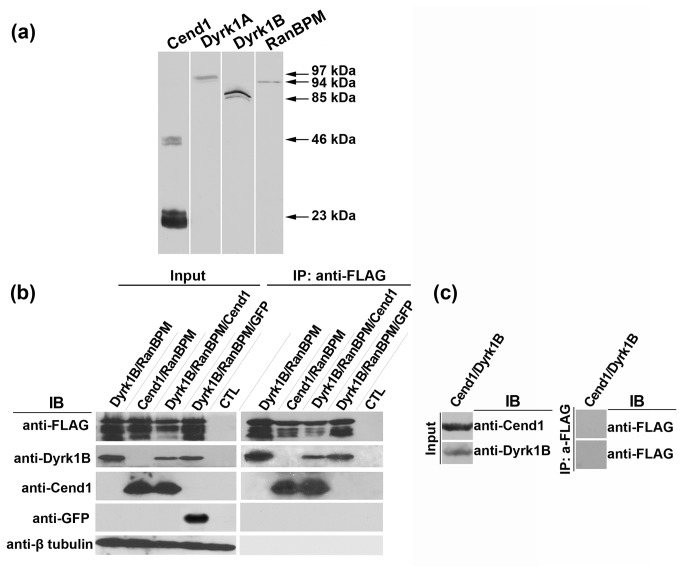
Cend1, RanBPM and Dyrk1B kinase are expressed in mouse brain and form complexes.(a) Mouse brain homogenate (60 μg of protein per lane) was subject to SDS-electrophoresis and immunoblotting with antibodies to Cend1 (lane 1), Dyrk1A (lane 2), Dyrk1B (lane 3) and RanBPM (lane 4). In lane 1 the 23kD band corresponding to the single polypeptide chain of Cend1 is seen as well as residual disulfide bond-linked 46kD homodimer [24,25]. (b) HEK293T cells were either not transfected (CTL) or transiently transfected with Cend1, RanBPM, Dyrk1B and GFP at the indicated combinations. Cells were harvested and RanBPM was immunoprecipitated from cell lysates using anti-FLAG antibody. Co-immunoprecipitated proteins were identified by Western blot using the indicated palette of antibodies. In the left panel, shown is the total cell lysate (input) with the different protein bands detected in each case. In the right panel, shown are the proteins which were co-immunoprecipitated with RanBPM in each case. (c) HEK293T cells were co-transfected with Cend1 and Dyrk1B and immunoprecipitated with anti-FLAG antibody. Note that anti-FLAG does not immunoprecipitate either of these proteins.